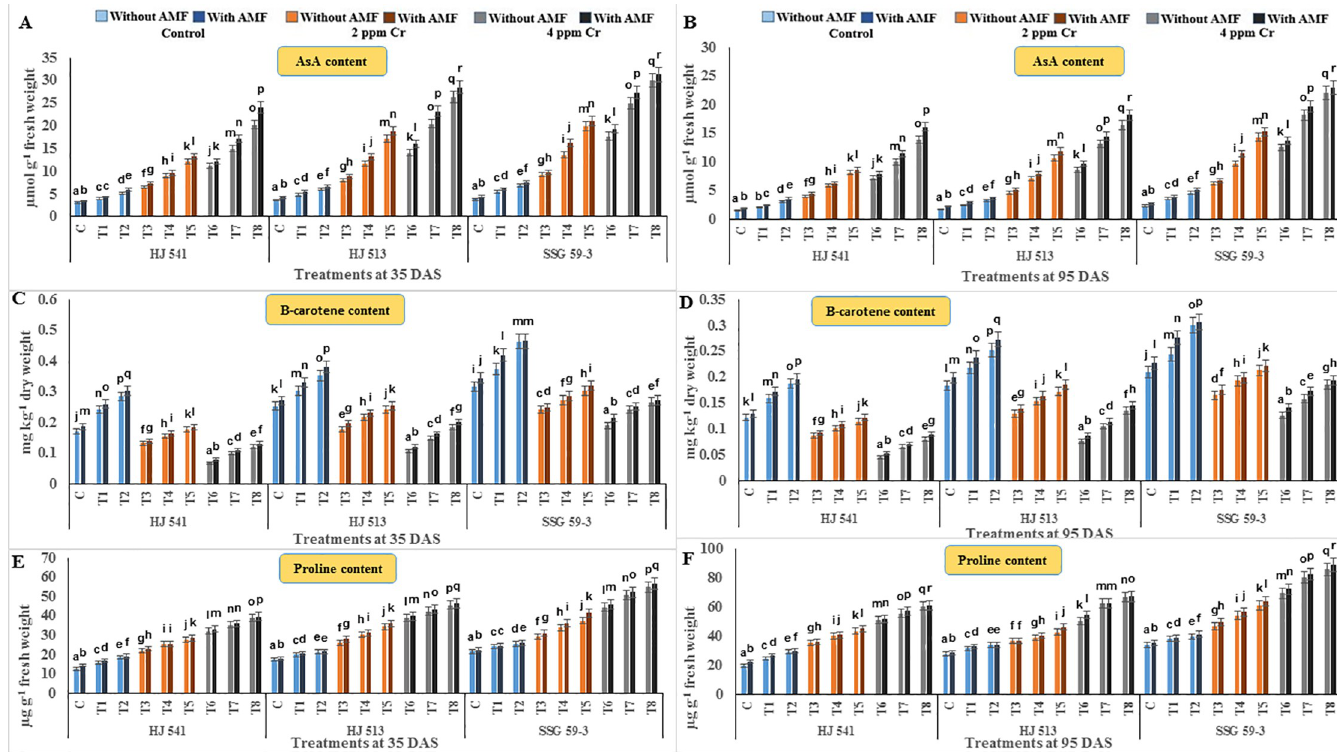
Fig 6. Effects on antioxidant metabolites viz . ascorbate (A and B), β -carotene (C and D) and proline (E and F) in different varieties of sorghum exposed to GB and AMF treatments under Cr toxicity at 35 & 95 DAS, respectively. Data are expressed as means of three replications with ± S.E., N = 3, from three independent experiments. Different letters above the bars in each column indicate significant differences among treatment means based on the least significant difference (LSD) test at P � 0.05.